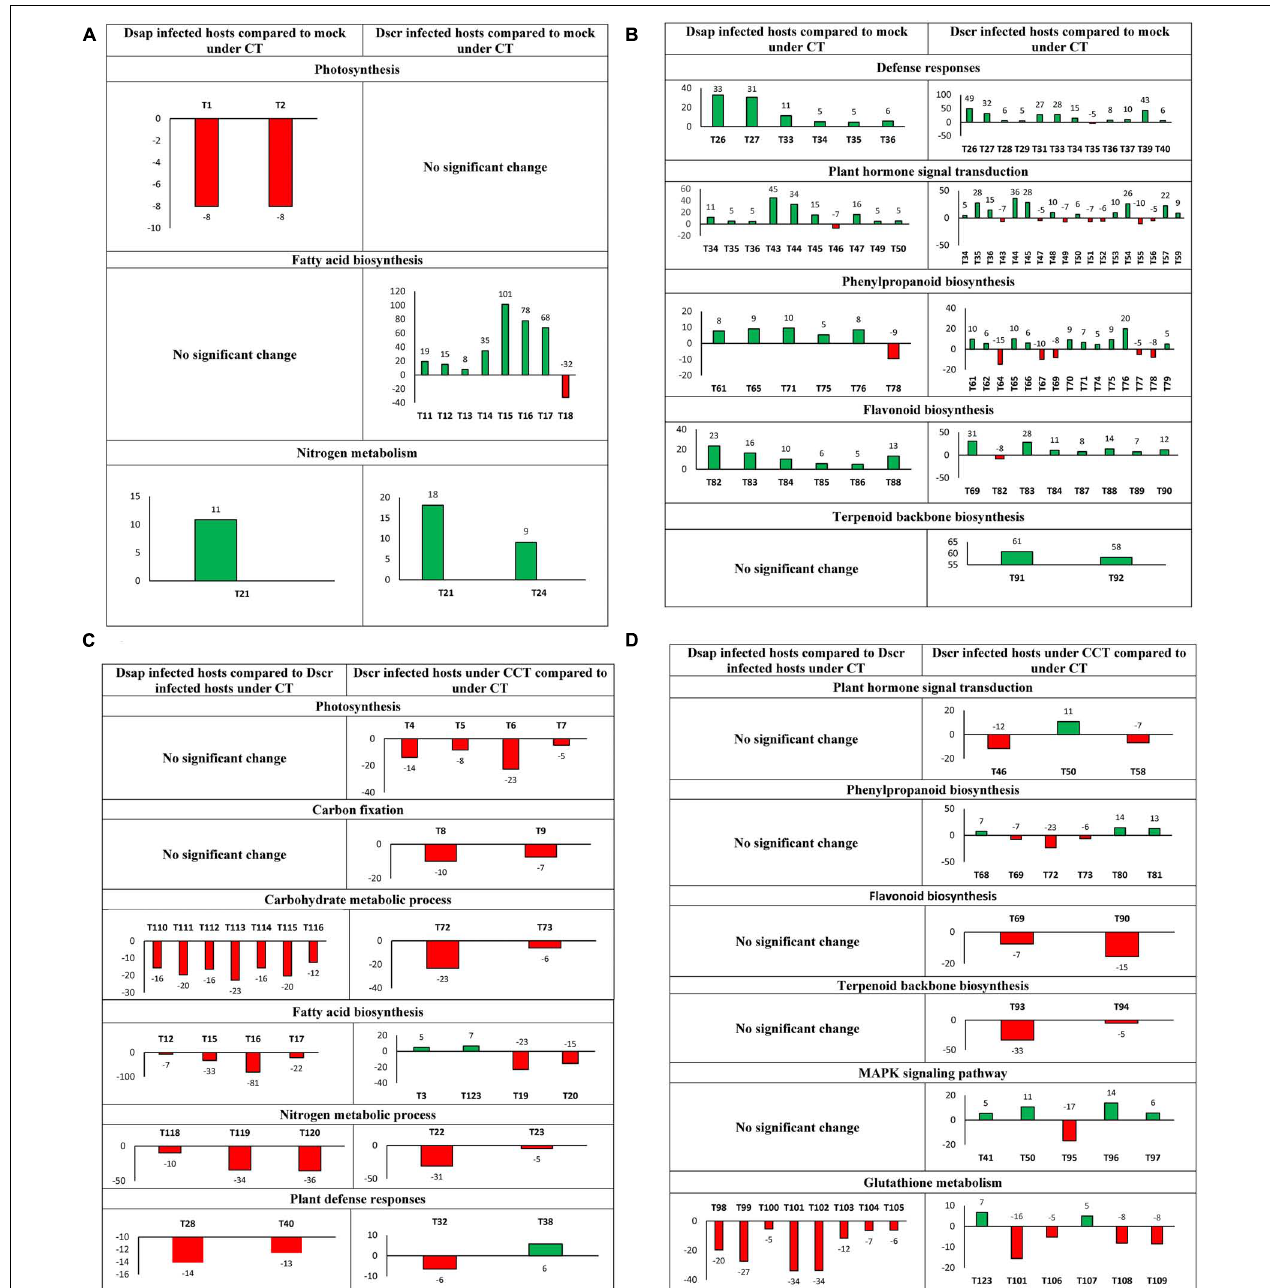
FIGURE 7 | (A) Most significant DEGs by actual fold-change ( Y -axis) > 5 (up) or < –5 (down) and p < 0.05, in host metabolic pathways (T = transcript): T1 – ATP synthase delta chain, T2 – photosystem II, T11–T14 – 3-oxoacyl-[acyl-carrier-protein] reductase (fabG), T15 – fatty acid synthase (FAS1), T16 – FAS2, T17–T18 – Stearoyl-[acyl-carrier-protein] 9-desaturase 7, chloroplastic (FAB2), T21 – carbonic anhydrase, T24 – Glutamate dehydrogenase A (gdhA) (Spreadsheet Host-comparison2 in Supplementary Information SI2 ). (B) T26–T29-calmodulin-like proteins (CML), T31-calmodulin (CALM), T33–T35- pathogenesis related 1 (PR1), T36-WRKY, T37–39-enhanced disease susceptibility (EDS1), T40-elongation factor (efTu), T43–T45-jasmonate domain protein (JAZ), T46–T47-auxin responsive protein, T49-Gibberellin Insensitive 1 (GID1), T50–T52 protein phosphatase 2C (PP2C), T53-coronatine insensitive protein (COI1), T54-age-related resistance-A (ARR-A) protein, T55-serine threonine protein kinase, T56–T57-xyloglucan endotransglycosylase (TCH4), T59-cyclin D3, T61–T62-cinnamoyl alcohol dehydrogenase (CAD), T64–T67-peroxidase, T69-caffeoyl CoA o-methyltransferase, T70–T71-beta glucosidase, T74–T77-4-coumarate CoA ligase, T78-cinnamoyl CoA reductase, T79-putative lysophospholipase, T82–T87-chalcone synthase, T88–T89-flavonoid 3 (cid:48) -monoxygenase, T90-anthocyanidin reductase, T91-acetyl CoA-acetyltransferase, T92-farnesyl pyrophosphate synthetase (Spreadsheet Host-comparison2 in Supplementary Information SI2 ). (C) T3-a/bccP, T4-ferredoxin, T5–T7-chlorophyll a-b binding protein, T8-fructose-1,6-bisphosphatase, T9-glyceraldehyde-3-phosphate dehydrogenase (GAPD), T12-3-oxoacyl-[acyl-carrier-protein] reductase (fabG), T15-fatty acid synthase (FAS1), T16-FAS2, T17-adaptor protein (fadD), T19–T20-myristoyl-acyl